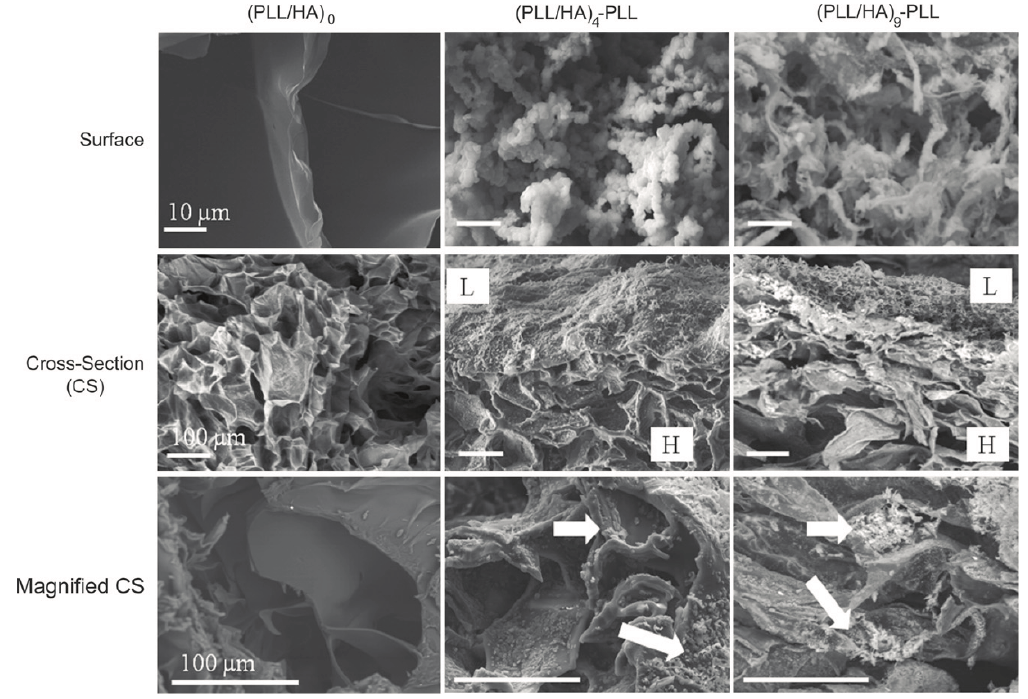
Figure 2. Scanning electron microscope (SEM) images of the top surface and cross-sections of HA MGs (left column) and microgels (MGs) coated with (PLL-HA) 4 -PLL, and (PLL-HA) 9 -PLL films (middle and right columns, respectively). The arrows indicate diffusion of the PEs into the gel. Reprinted with permission from [37], copyright 2011,